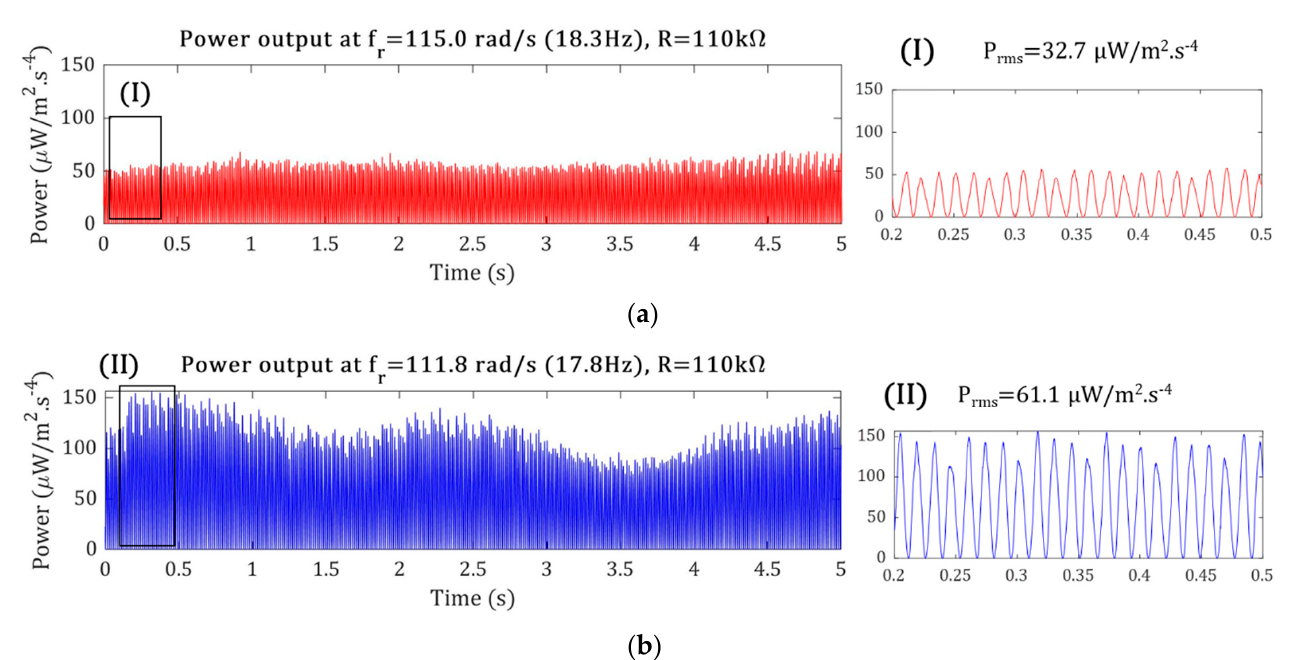
( c ) Figure 13. Normalized power per acceleration under ( a ) f r = 18.3 Hz and R = 10 k Ω , (I) is the zoomed- in view for (a), ( b ) f r = 17.8 Hz and R = 10 k Ω , (II) is the zoomed-in view for (b), and ( c ) different motor rotations with non-optimum (56 k Ω ) and optimum-resistance loads (110 k Ω ). 5.2. Toward a Self-Powered Online Condition Monitoring System An energy of 360 µJ is needed for a fully autonomous wireless vibration [34]. For energy-storing investigation, a 100 µF capacitor is connected to the PG, and the stored energy at various motor rotation speeds is measured, as shown in Figure 14. As can be seen from Figure 14, at 𝜔 (cid:3038) equals to 2 × 14.9 and 2 × 18.3 Hz, the stored energy crosses the threshold, while for low-rotation speeds, the stored energy does not reach the thresh- old in 100 s. For satisfying the autonomous condition monitoring, the power requirements shall be met at all the operating rotation speeds. Thus, in some rotation speeds, more than one PG is required. Figure 14. The stored energy for a 100µF capacitor at different motor rotation speeds.